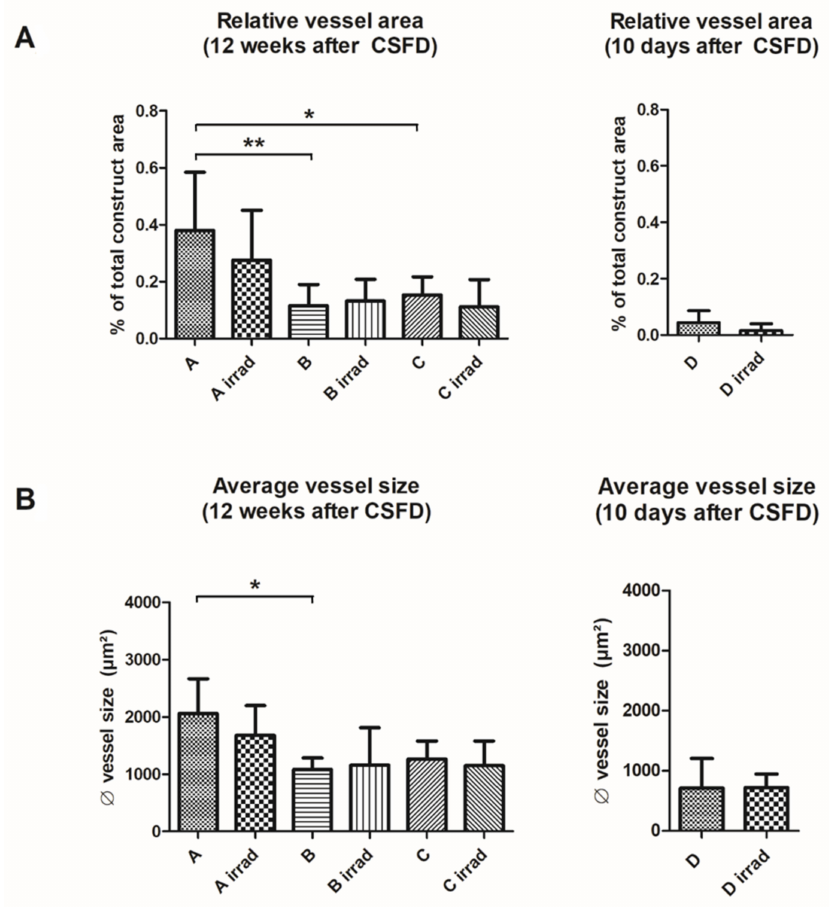
Figure 8. Vascularization of implanted constructs 12 weeks (group A/B/C, A irrad/B irrad/C irrad) and 10 days (D/D irrad) after CSFD surgery. ( A ) The relative vessel area was low in short- term groups D and D irrad and increased after 12 weeks in all groups. Empty defects (group A) showed a significantly higher relative vessel area than defects filled with hydroxyapatite alone (group B; ** p ≤ 0.01) or hydroxyapatite/BMP-2/MSCs (group C; * p ≤ 0.05). The differences between irradiated defects and unirradiated controls were not significant. ( B ) Similar to the relative vessel area, vessels in empty defects (group A) were significantly larger than hydroxyapatite-filled defects (group B; * p ≤ 0.05). The differences between irradiated and unirradiated groups were not significant. Values are given as mean ±